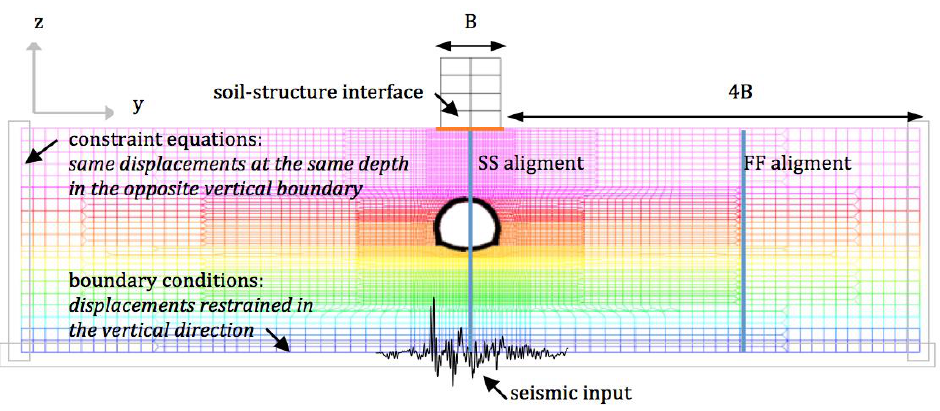
Figure 2. FEM model adopted.